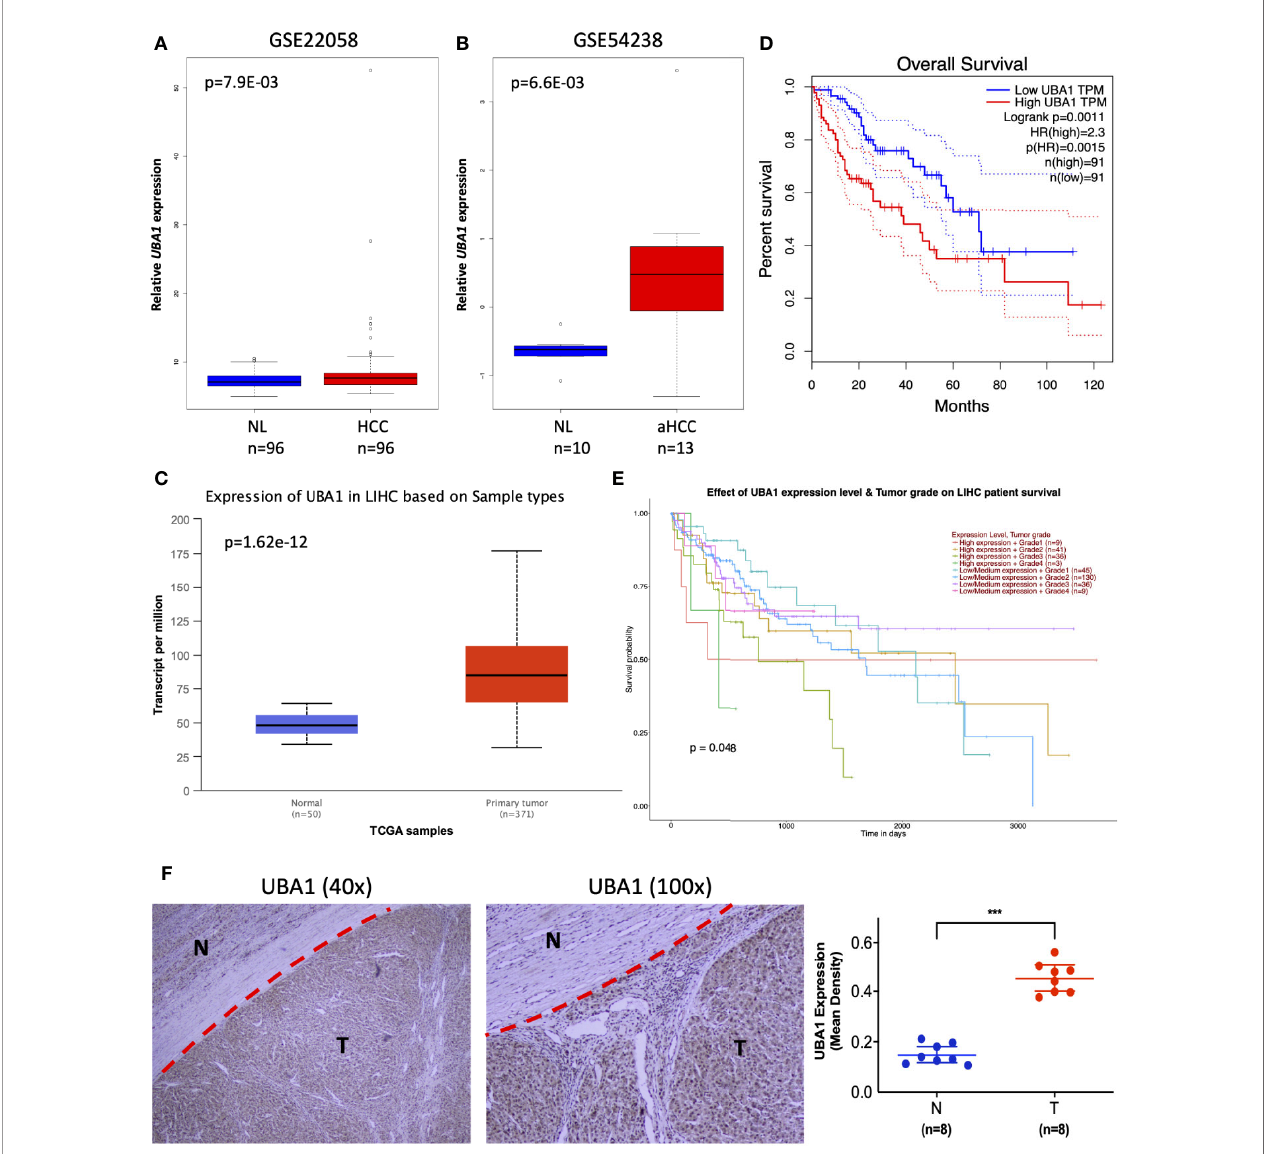
FIGURE 6 | Clinical implication of UBA1 . (A – C) The UBA1 expression levels are shown in GSE22058 (n=192), GSE54238 (n=23), and TCGA HCC data (n=421). (D) Kaplan – Meier survival curve of differentially expressed UBA1 (HR=1.49; p =0.026). The red dotted line above the red curve and red dotted line below represent the high (50%) and low cutoff (50%) on the survival curve. The blue dotted line above the blue curve and blue dotted line below represent high (50%) and low cutoffs (50%) on the survival curve. (E) Differentially expressed UBA1 is associated with HCC grade ( p =0.048). (F) Representative images (left) and quanti fi cation (right) of UBA1 immunohistochemical staining in eight HCC and paired nontumor tissues, ***p <